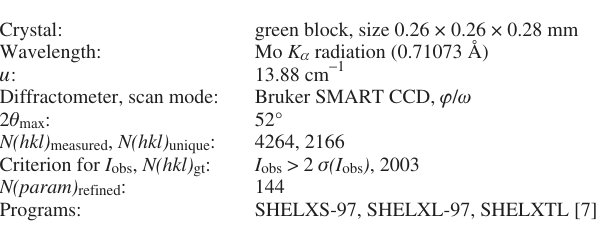
Table 1. Data collection and handling.